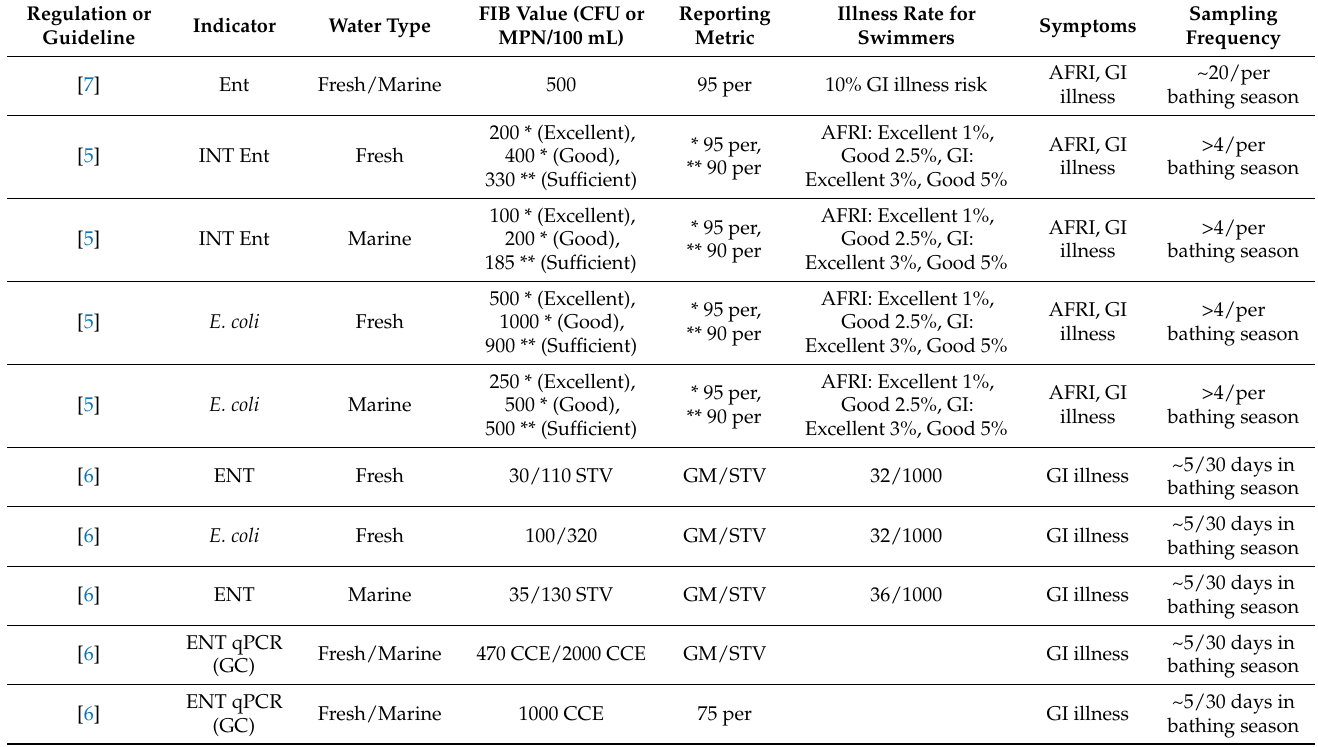
Figure 1. Bathing water health risk classification matrix based on FIB enumeration and sanitary inspection [7]. Table 2. Bathing and recreational water standards, regulations, guidelines, and indicators on freshwater and marine bathing sites. INT Ent = intestinal enterococci, ENT = enterococci, GC = gene copies, STV = statistical threshold value, CCE = calibrator cell equivalents, per = percentile, GM = geometric mean, AFRI = acute febrile respiratory illness, and GI = gastroenteritis